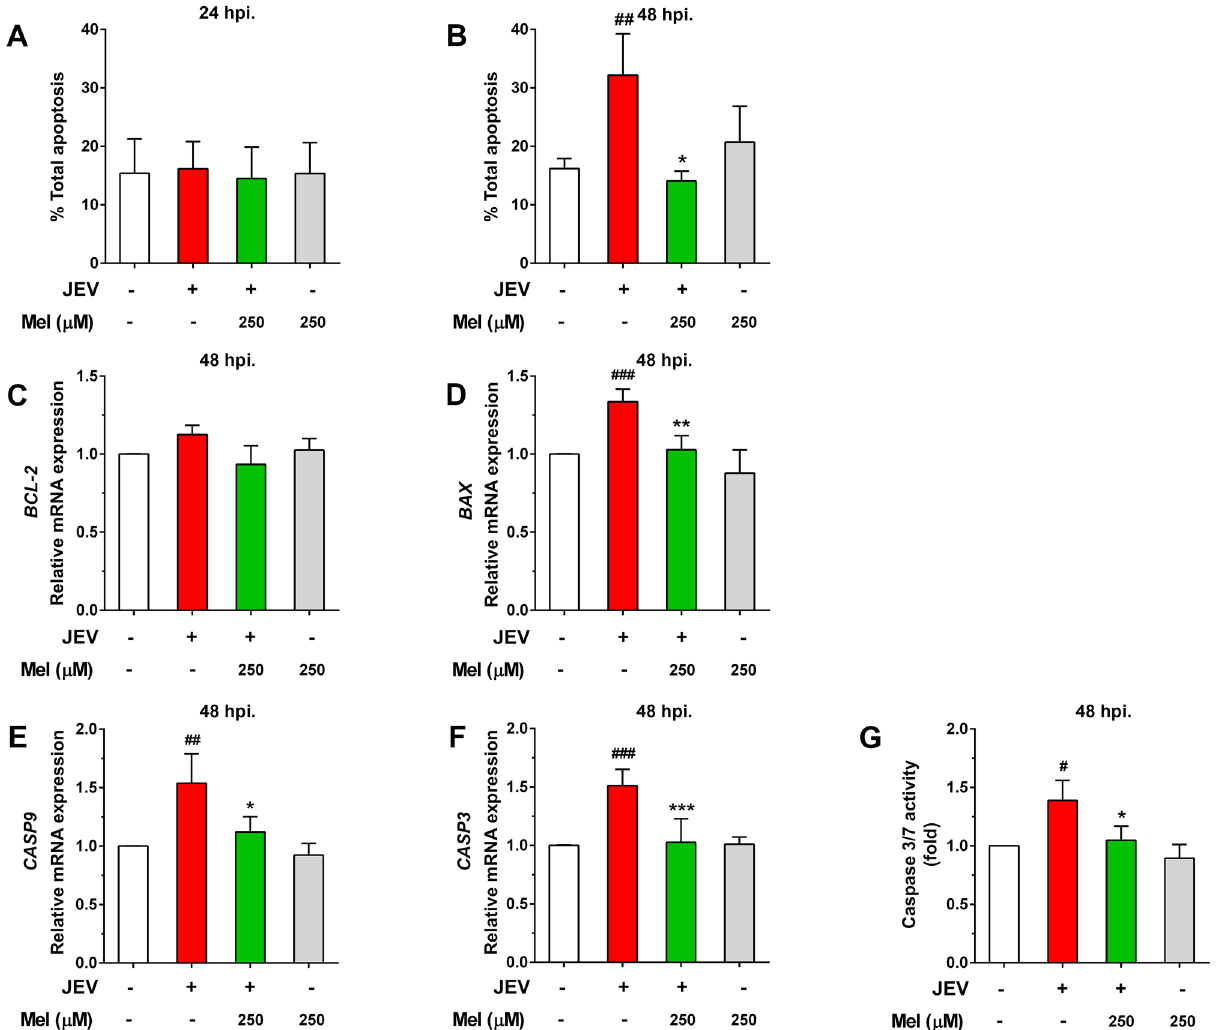
Figure 6. The effect of melatonin (Mel) on the apoptosis pathway in JEV-infected SH-SY5Y cells. Cells were pre-treated with melatonin at various concentrations and infected with 0.1 MOI of JEV. The cells were maintained in the presence of melatonin for 24 or 48 h. The infected cells were collected, and the number of apoptotic cells was measured by flow cytometry at ( A ) 24 hpi and ( B ) 48 hpi. The mRNA expression of apoptosis-related genes at 48 hpi was determined by qPCR. ( C ) BCL-2 , ( D ) BAX , ( E ) CAS9 , and ( F ) CAS3 . ( G ) The caspase-3/7 activity of JEV-infected cells was measured at 48 hpi. The graphs show the means ± SD of three independent experiments. One-way ANOVA and Tukey–Kramer multiple comparisons tests were performed for statistical analysis. # p < 0.05, ## p < 0.01, and ### p < 0.001 compared to the cell control. * p < 0.05, ** p < 0.01, and *** p < 0.001 compared with the JEV-infected